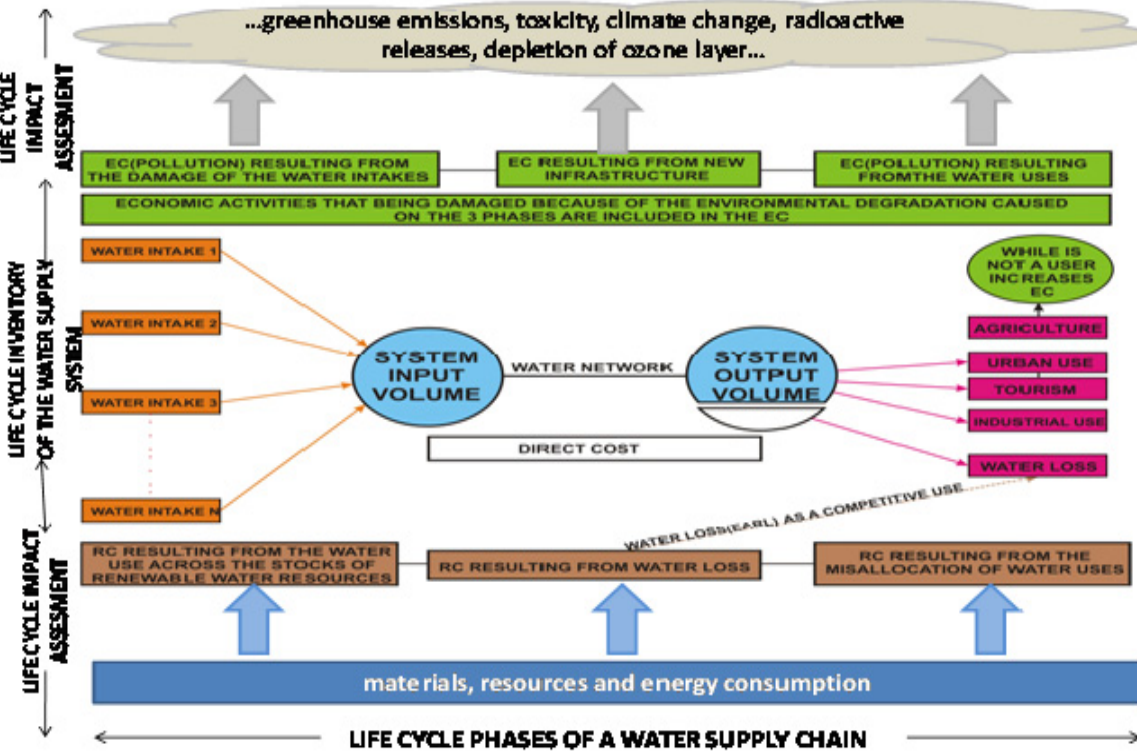
Figure 2. Water supply system life cycle with data collection of a water network, resources and emissions followed by the impact assessment of emissions and resource